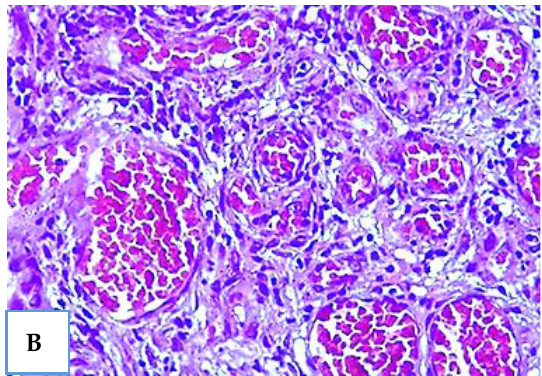
B Figure (2-B): Photomicrograph lobular PG 10x